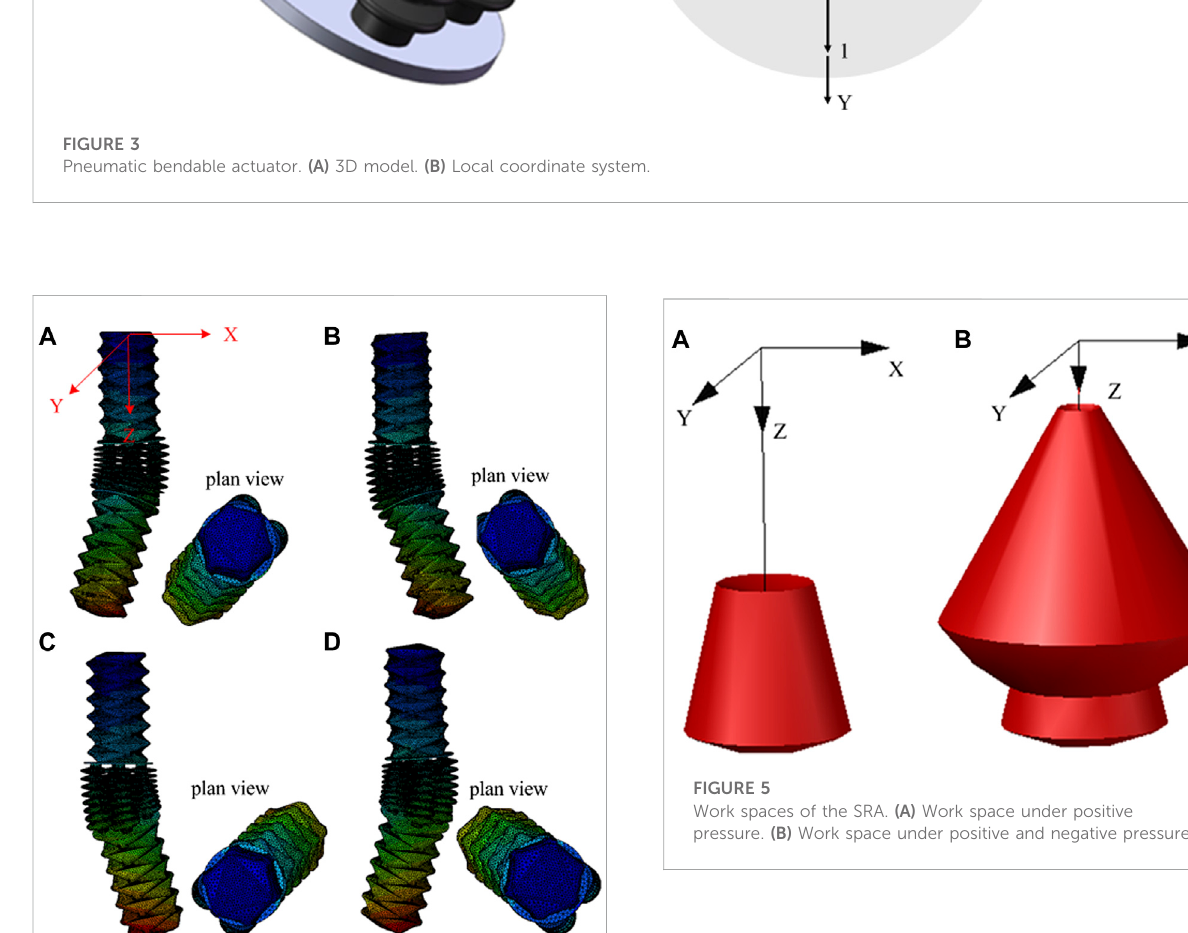
FIGURE 4 Simulationresultsofmotionability. (A) Moveto fi rstquadrant. (B) Movetosecondquadrant. (C) Movetothirdquadrant. (D) Move to fourth quadrant.